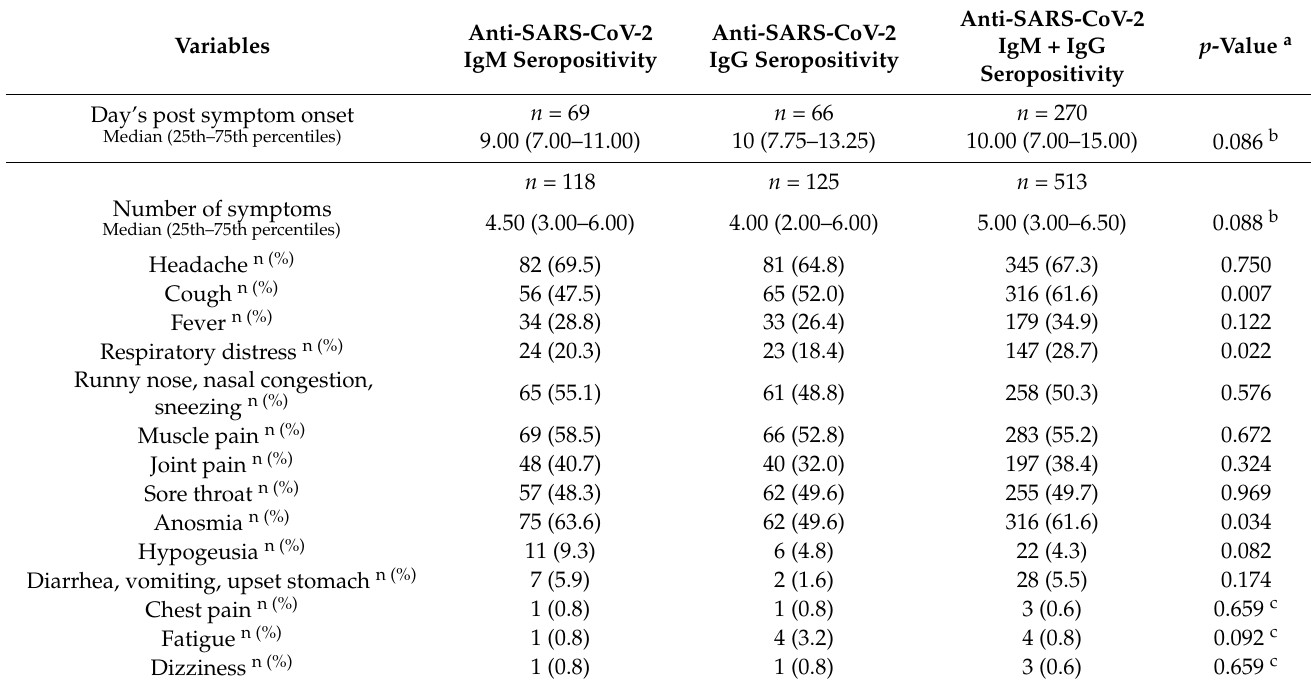
Table 3. Symptoms according to seropositivity to anti-SARS-CoV-2